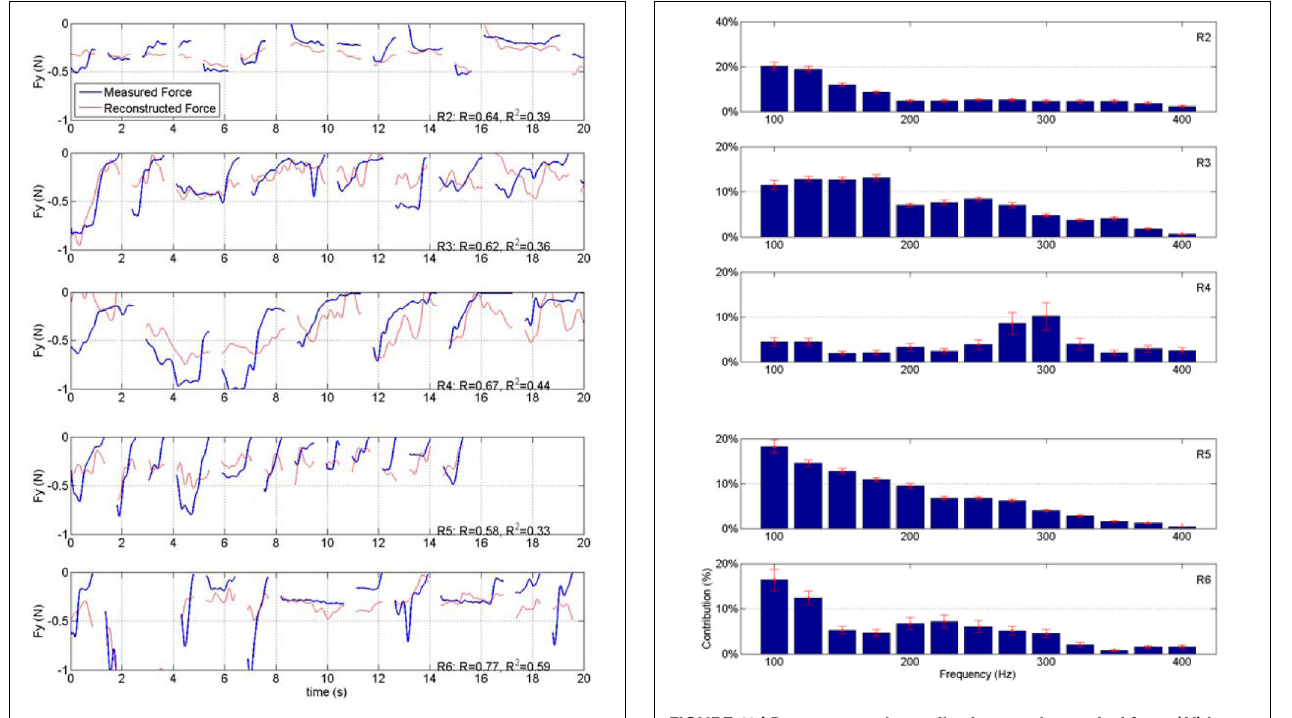
FIGURE 10 | Plot of measured and reconstructed forces in the test sets from rats 2, 3, 4, 5, and 6 of the study (R1 is shown in Figure 7). Only the vertical forces are shown. Correlations and R 2 values are indicated on each plot.